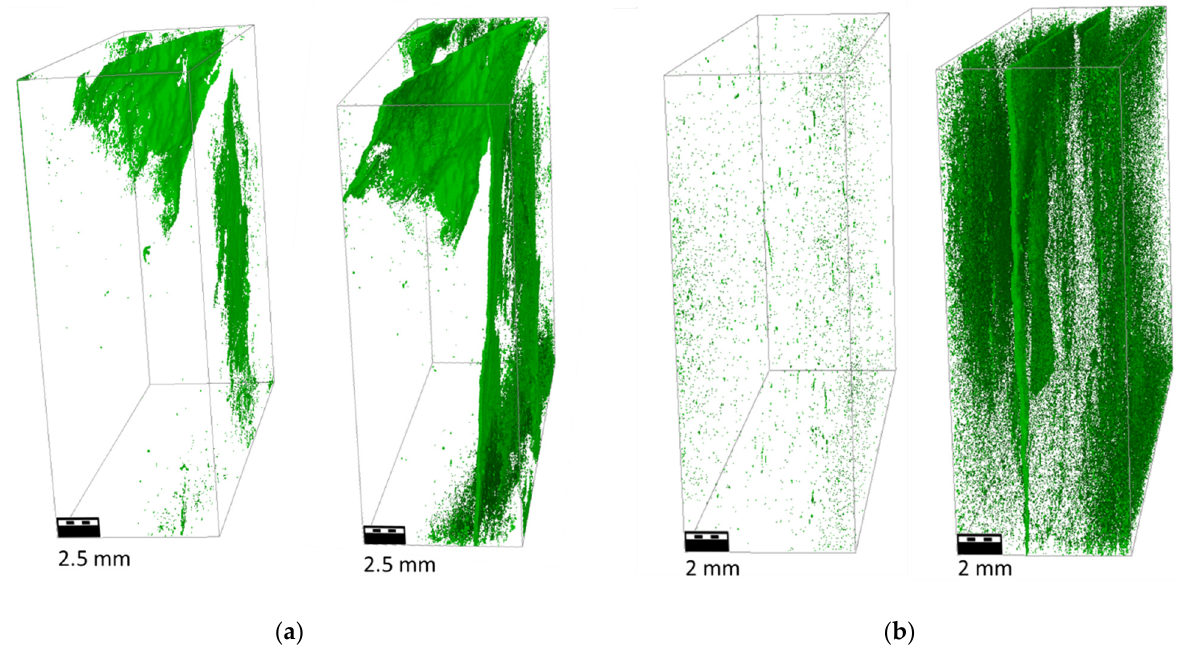
Figure 6. X-ray computed microtomography results: sample BF13 (a) before (left) and after treatment (right); sample BF15 (b) before (left) and after treatment (right).